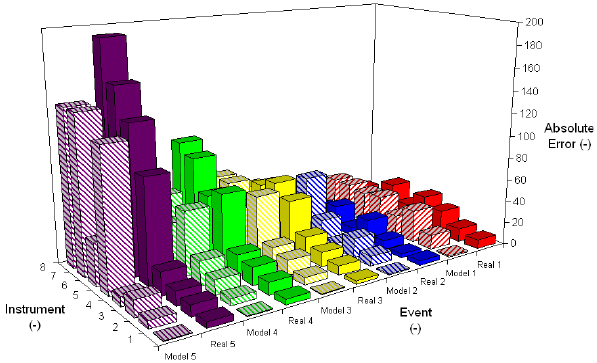
Figure 1. Model predicted vs. actual data sensitivity (for looped